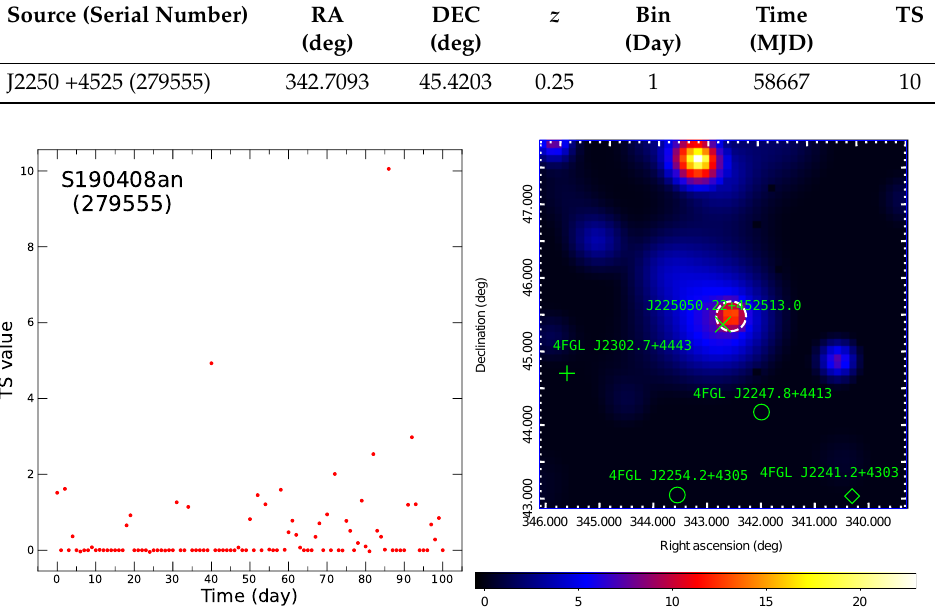
Figure 3. ( Left ): The 1-day binned TS curve from − 1 to 100 days of the BBH merger trigger S190408an obtained for J225050.22+452513.0 (279555). A TS (cid:39) 10 event is seen at 86days. ( Right ) The 0.3–500 GeV TS map with a size of 5 ◦ × 5 ◦ made for the high-TS data point on the left. The 4FGL sources in the field are marked with circles, a diamond and a plus sign, the latter two indicating a Log-Parabola and a PLSuperExpCutoff spectral form, respectively, for the two sources. The position of the galaxy target is marked with a cross, while a dashed white circle is the 2- σ error circle (0.2deg) determined for the candidate γ -ray